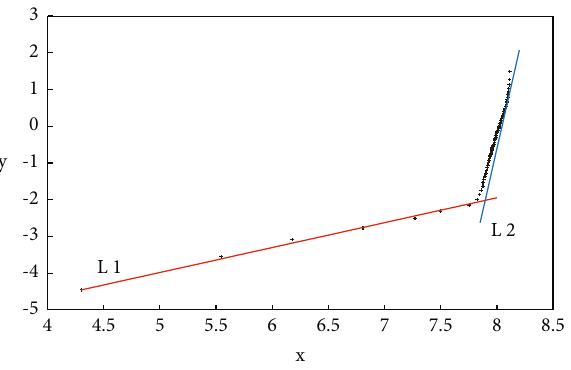
Figure 4: WPP diagram of the segmented model. Table 3: Calculation results of WPP graph method parameters. Parameter